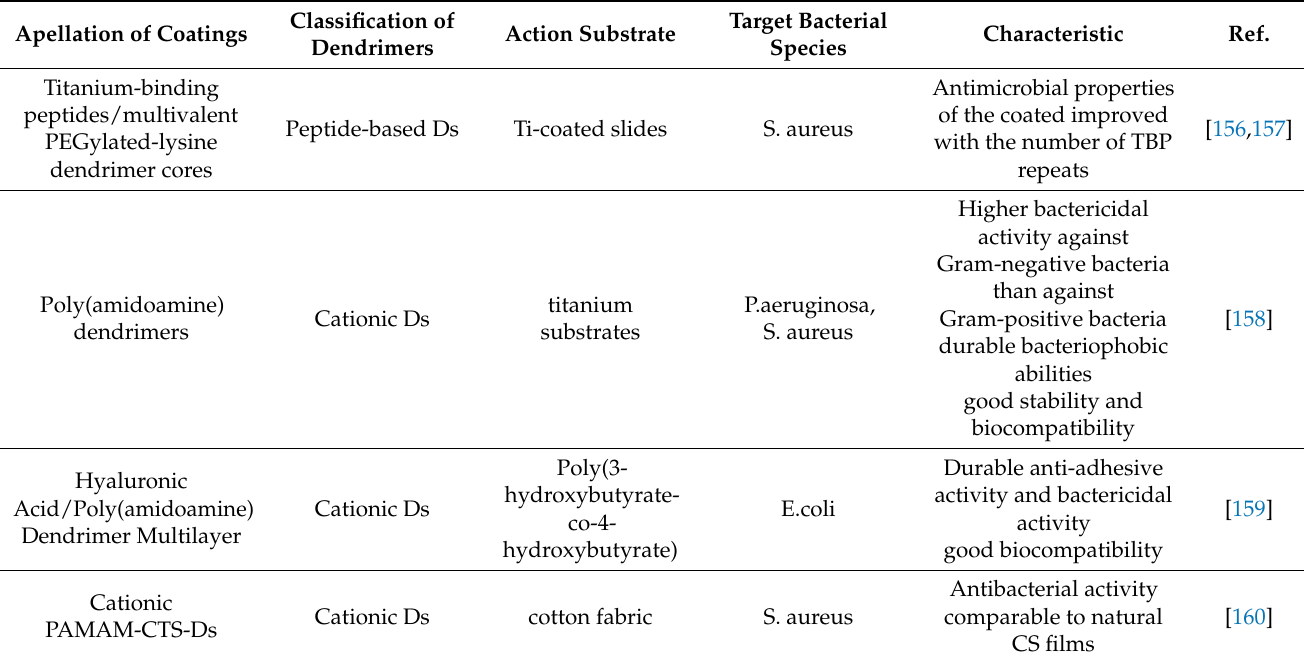
Table 4. Dendrimers (Ds) in antimicrobial surface